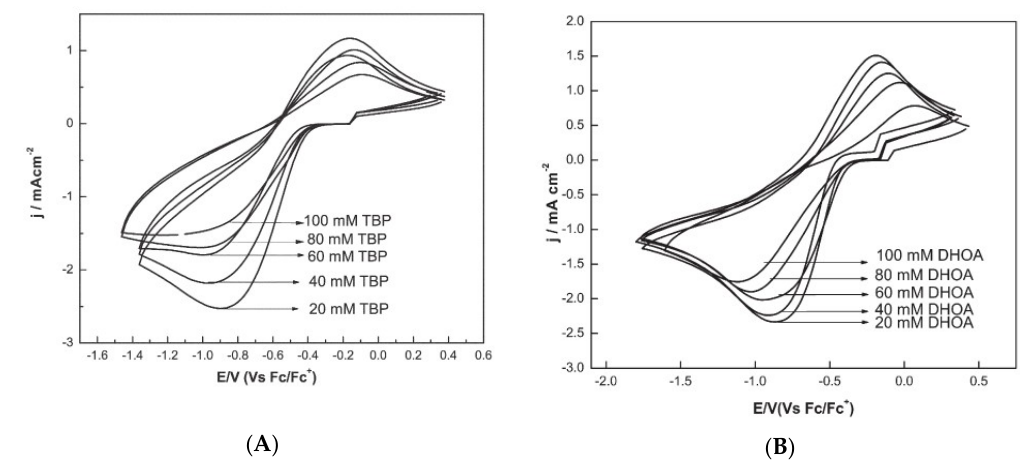
Figure 5. Cyclic voltammograms of Eu(III) (100 mM) recorded at glassy carbon electrode at a scan rate of 100 mV s − 1 and at 373 K, in ( A ) TBP / [hmim][NTf 2 ] or ( B ) in DHOA / [hmim][NTf 2 ]. Reproduced with permission of ref. [35], copyright, 2015, Springer.